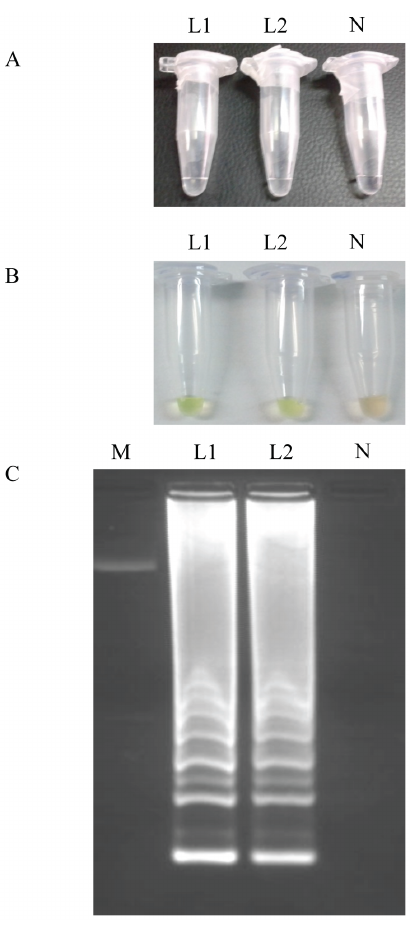
Figure 2. LAMP detection of Loaloa genomic DNA samples. (A) By the naked eye; (B) by adding SYBR Green I; (C) on agarose gel stained with ethidium bromide. Lanes L1 and L2: Loa loa adult worm genomic DNA; lane N: no template (negative control); lane M: 50 bp DNA ladder (Molecular weight marker XIII, Roche).